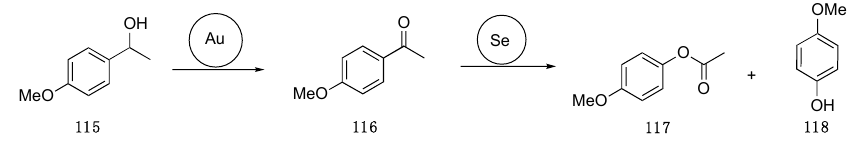
Table 6. Lignin model compounds